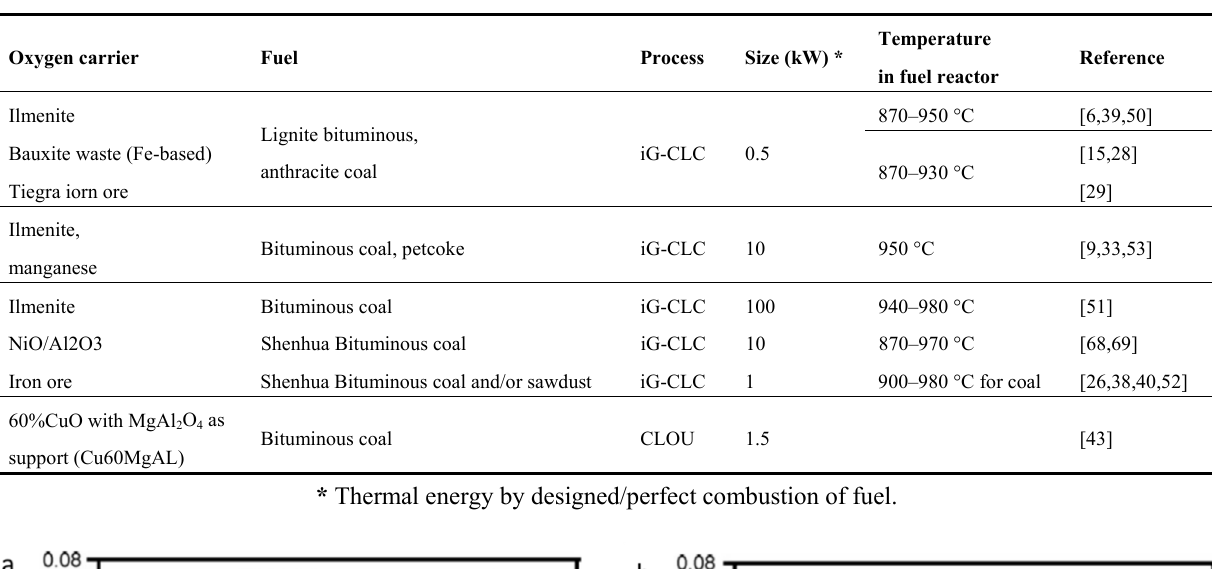
Table 2. Pilot scale tests of the coal direct CLC process in two interconnected continuous fluidized beds reactors.